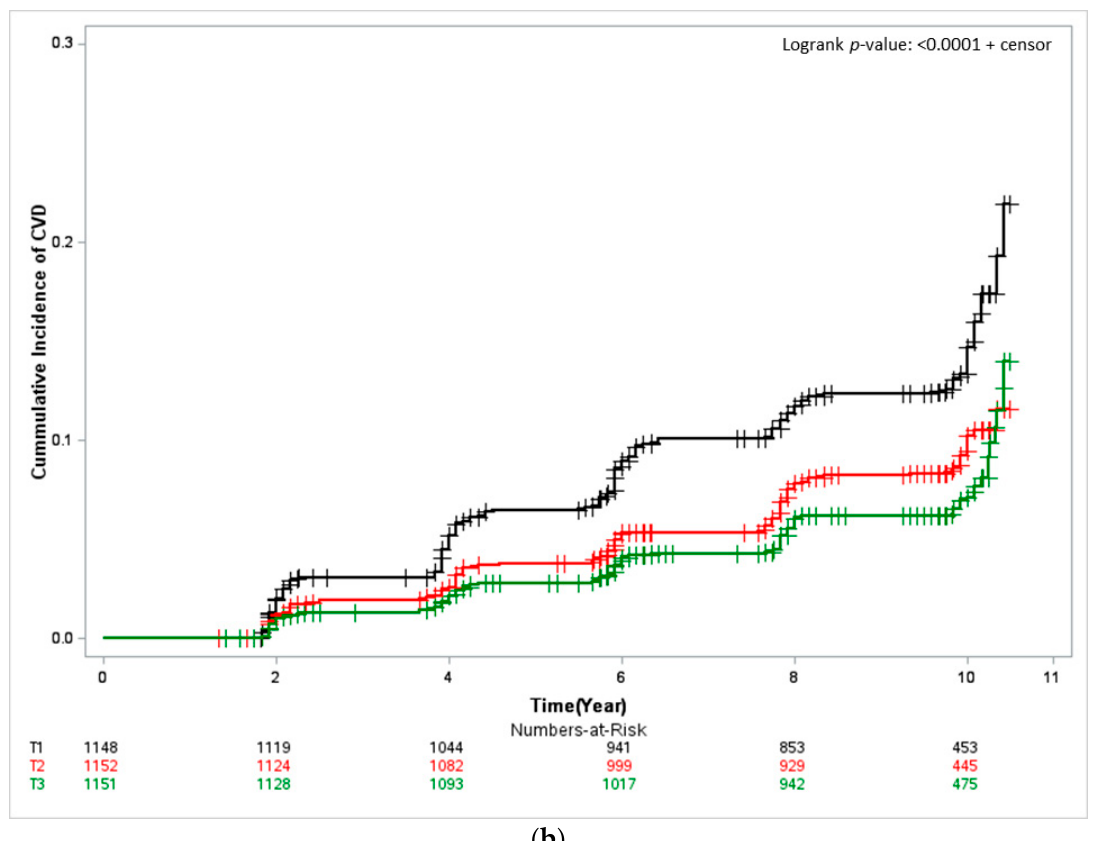
Figure 1. Kaplan–Meier curves showing the cardiovascular disease (CVD) cumulative incidence according to seafood-intake tertile. The log-rank test was used to determine risk differences among groups. ( a ) Male and ( b ) Female. T1, first tertile, black; T2, second tertile, red; T3, third tertile, green.